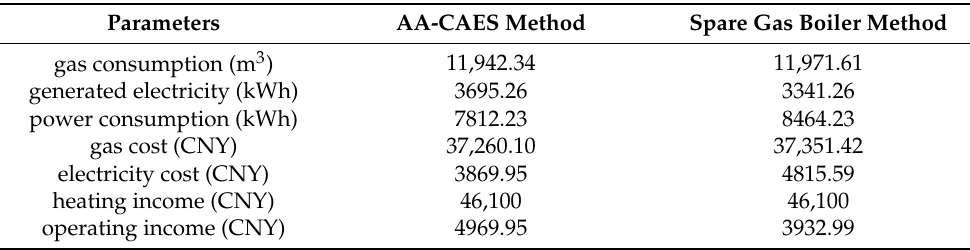
Table 5. Dynamic operating income of the